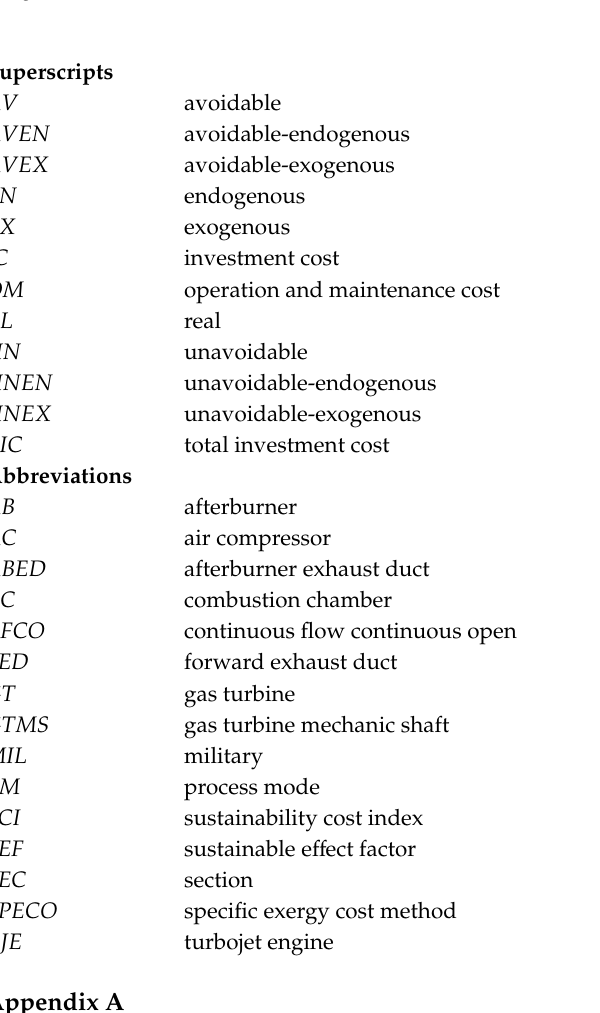
Table A1. Values for energy rate, exergy rate, mass flowrate, pressure and specific heat capacity for the system sections for JP-8 fuel utilization (*: solely for Afterburner (AB) process mode) [63]. State